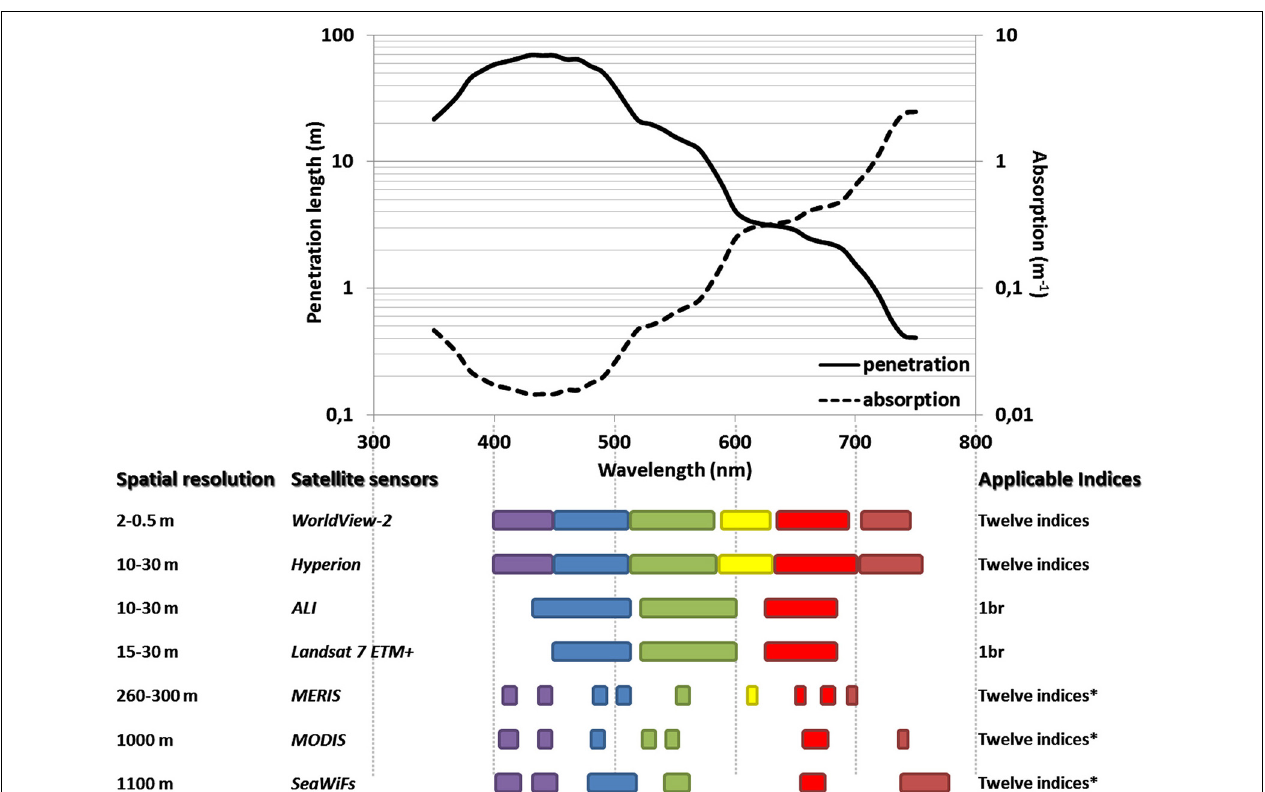
FIGURE 9 | Theoretical limit of water depth detection in regard to the spectral capabilities of the satellite sensors. The seven sensors, including WV2 studied here, are very susceptible to provide meaningful spatial data for